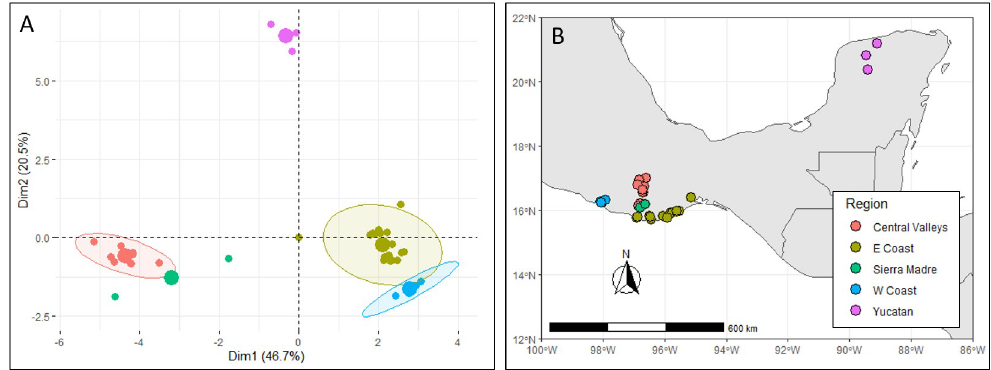
Fig 1. The five biogeographic ecozones from which we collected chile pepper accessions in Mexico. Identified on a principal component analysis (PCA) of elevation and bioclimatic (A), and by geographical distribution of accessions within those ecozones (B). This figure was created using data from WorldClim [42] and Natural Earth. The packages ‘FactoMineR’ [43] and ‘raster’ [44] were used in the R statistical environment (ver. 3.5; R Development Core Team,